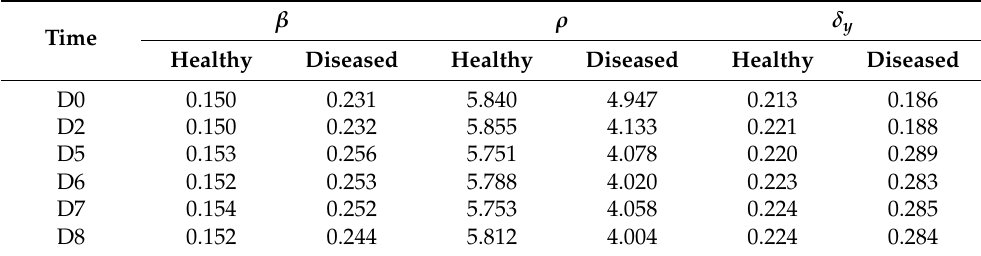
Table 4. The values of β , ρ and δ y associated with the fluorescence data on Healthy and Diseased plants of the bacteria data set. D0, ..., and D8 are the six days of the acquisition of chlorophyll fluorescence